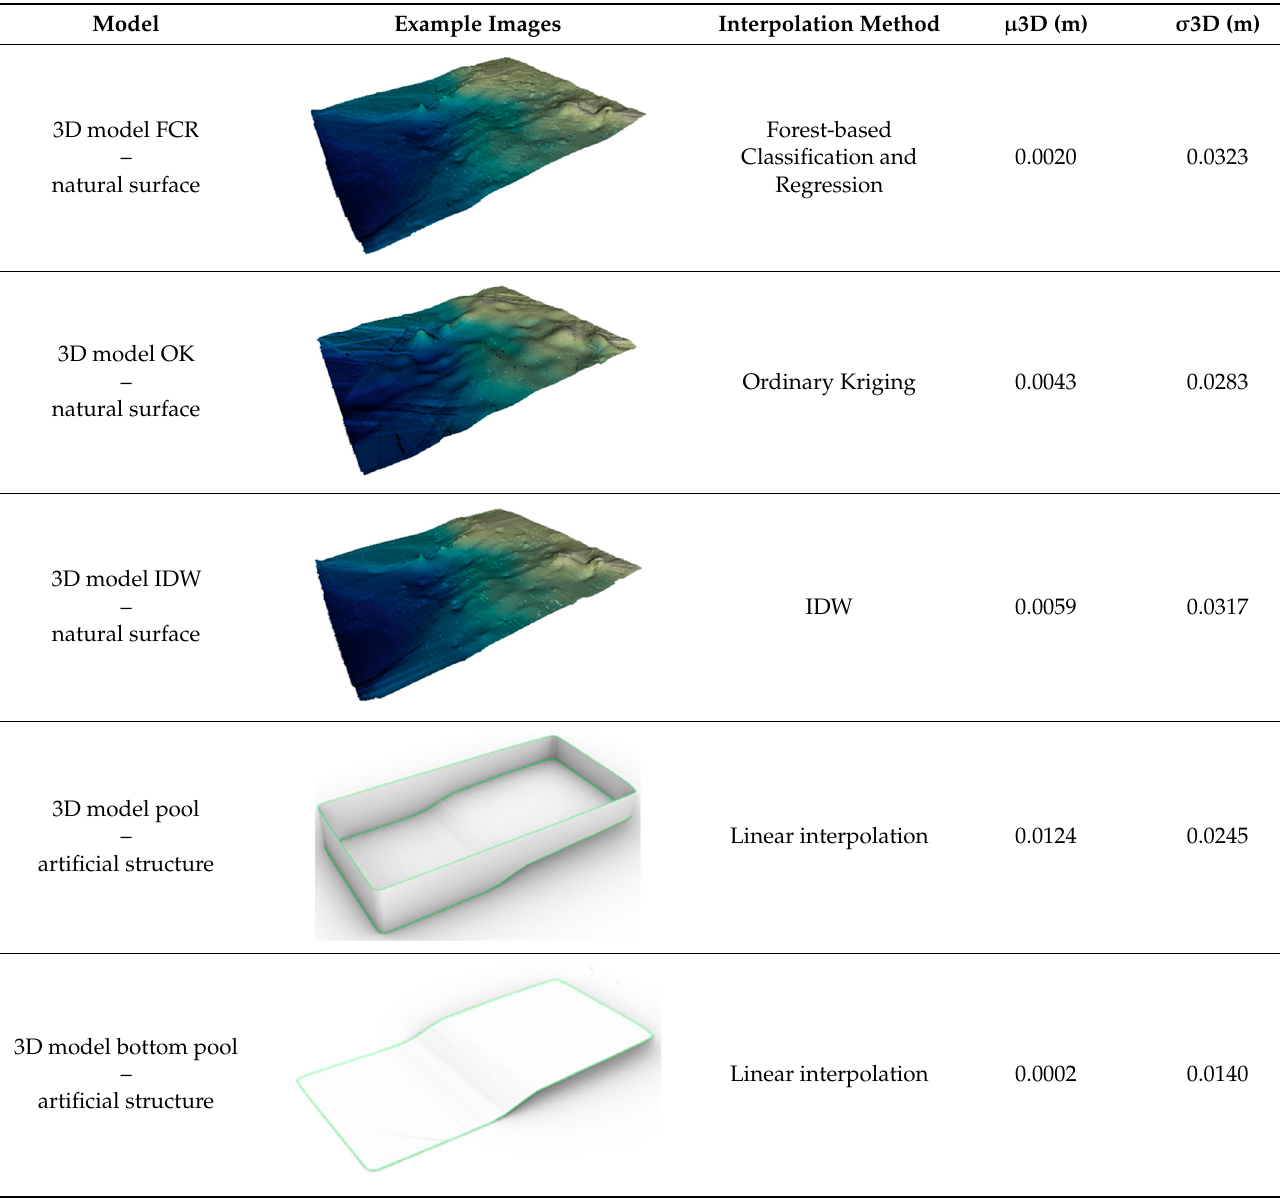
Table 13. Performance in depth measurement of Deeper Smart Sonar CHIRP+ and Deeper Smart Sonar Pro+ 2.